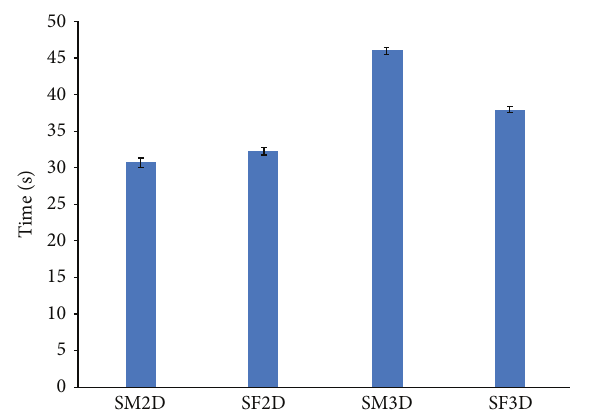
Figure 12: Computation time for the four methods to reconstruct the DT-MR data: the blue solid bar and small vertical bar at the top end of the blue bar represent the average and the standard deviation of computational times for the four methods, respectively, after testing the four median filters five times for